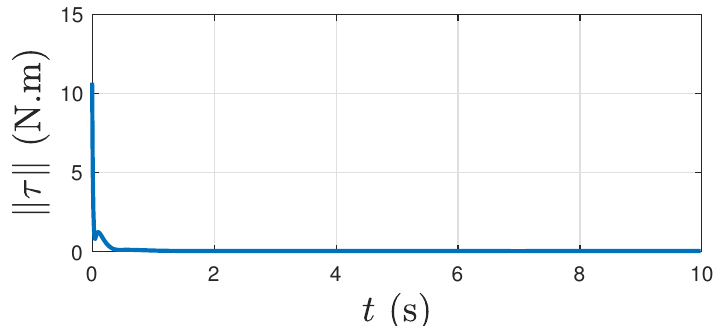
Figure 14. Magnitude of control torque versus time for D = 0.